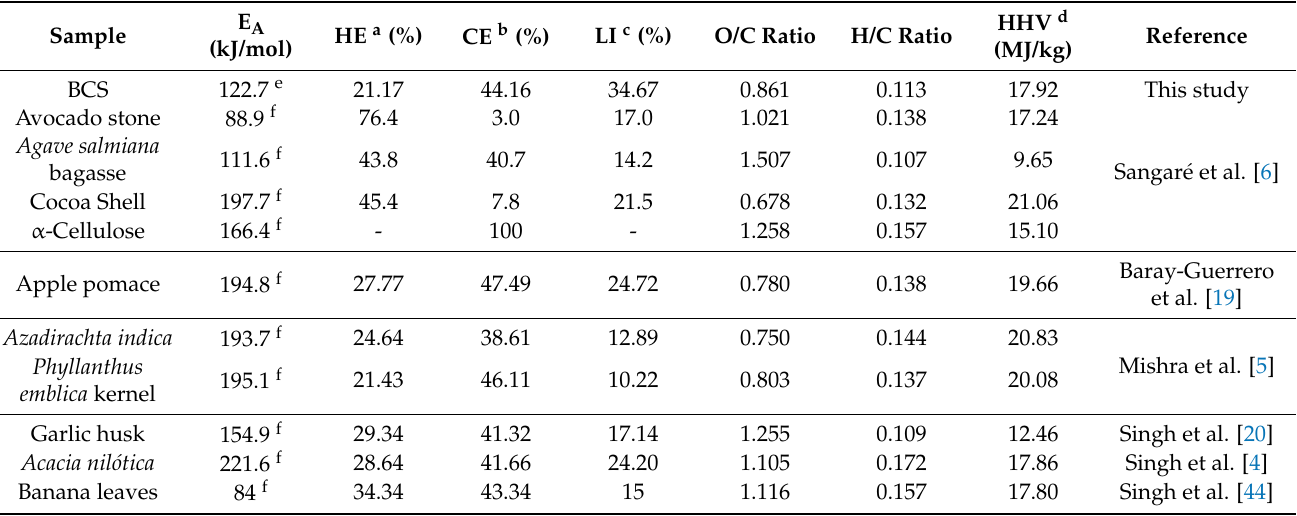
Table 3. Comparison of apparent activation energy, structural composition, elemental ratios, and HHV values by different biomass.